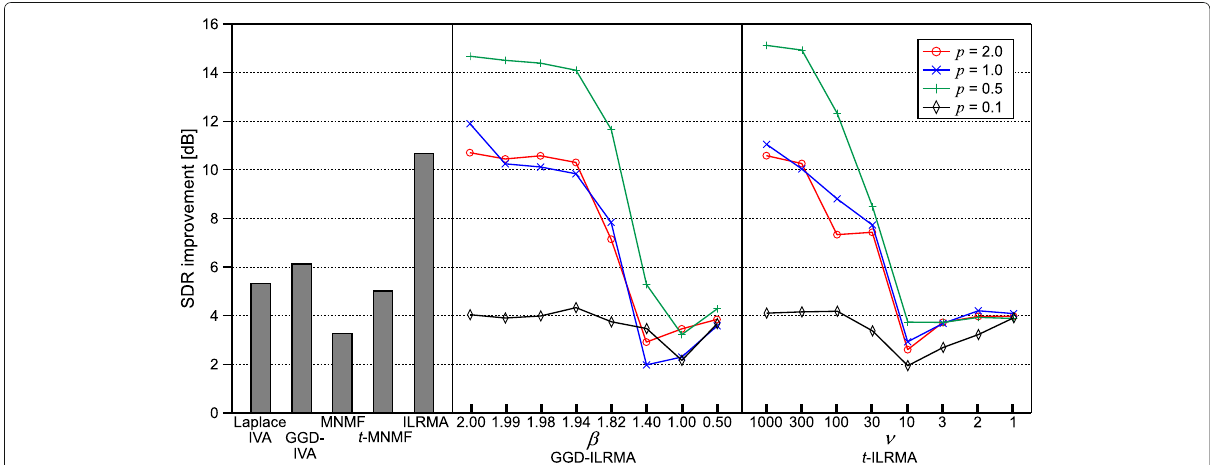
Fig. 7 Average SDR improvements of Music 1 signal with E2A_1 using fixed parameters. The results for GGD-IVA and t -MNMF using β = 0.5 and ν = 1 are shown, which are their best parameter settings